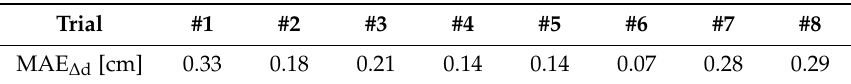
Table 2. MAE ∆ d values used to quantify the di ff erence between the distance ∆ d L3 − L1 and the reconstructed distance ∆ d ∆ λ B